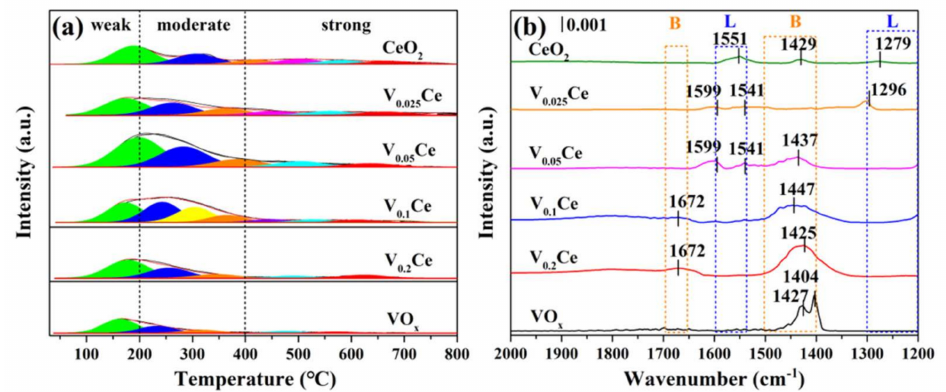
Figure 7. ( a ) Temperature programmed desorption of NH 3 (NH 3 –TPD) and ( b ) FT–IR spectra